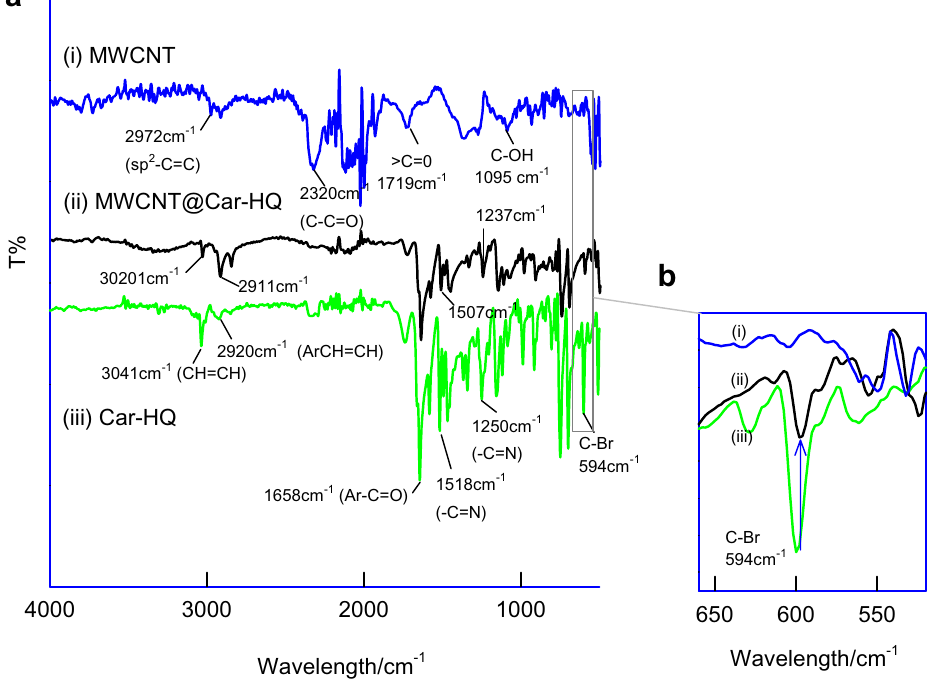
Figure 6. ( a ) FTIR/KBr responses of MWCNT (i), (ii) MWCNT@Car-HQ and (iii) Car-HQ samples and ( b ) Enlarged FTIR responses of the sample at a limited